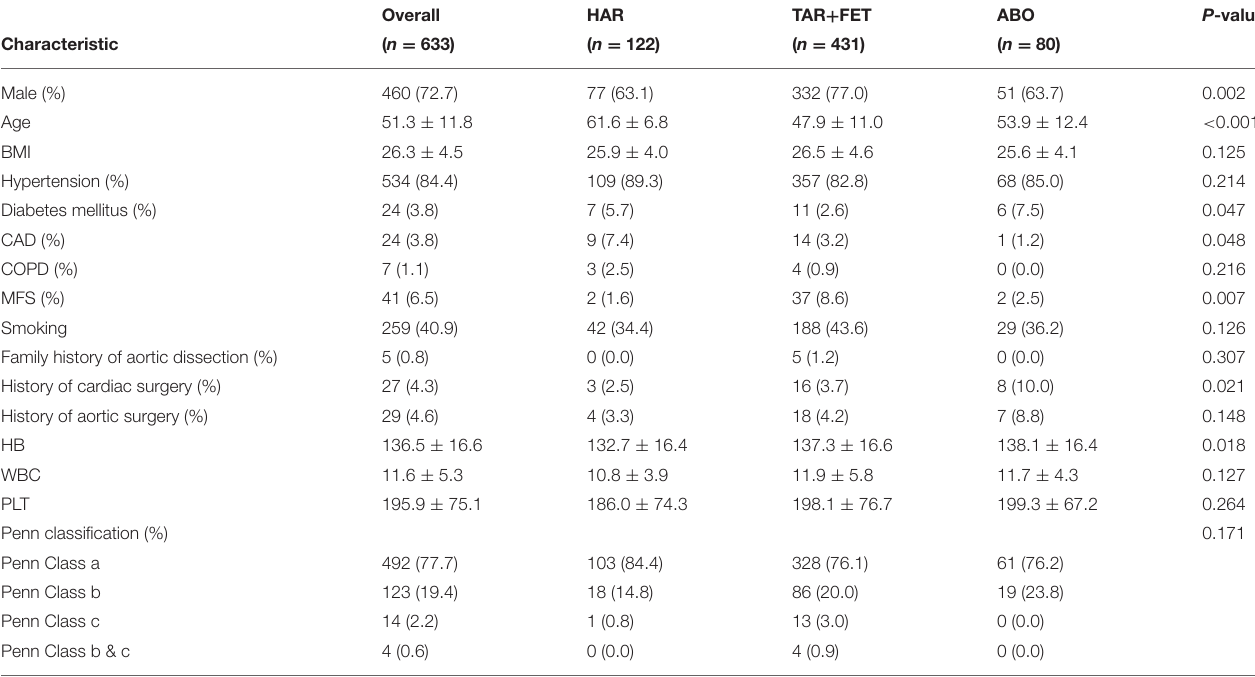
TABLE 1 | Preoperative characteristics of the total cohort and each group before using the matching weight method. Overall HAR TAR + FET ABO P